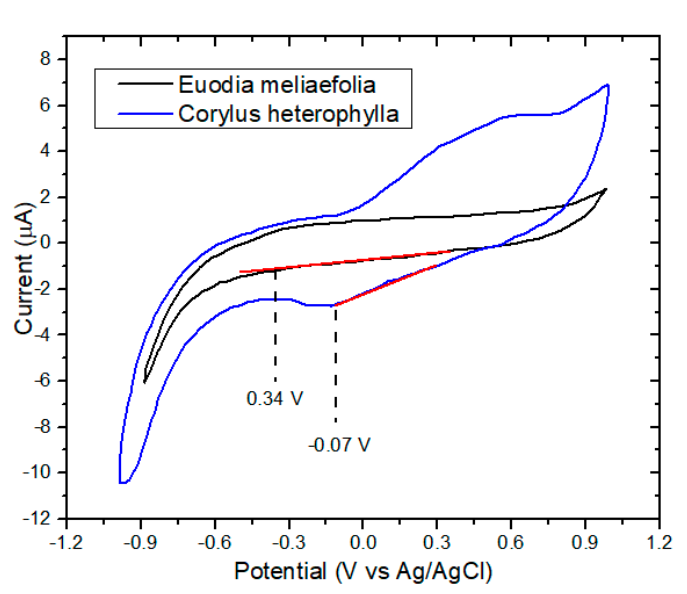
Figure 3. Voltammograms of natural dyes in 0.1 mol L − 1 KNO 3 at 50 mV s − 1 with glassy carbon as a working electrode and Pt wire as counter electrode. Adapted from